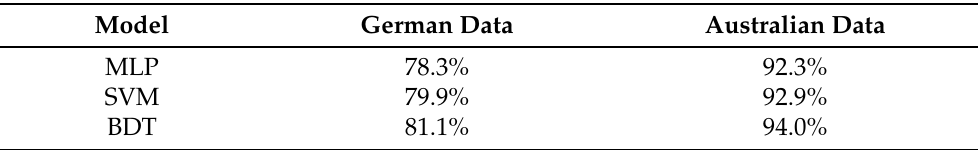
Table 1. Comparison of the area under the ROC curve for the multilayer perceptron (MLP), support vector machine (SVM), and boosted decision trees